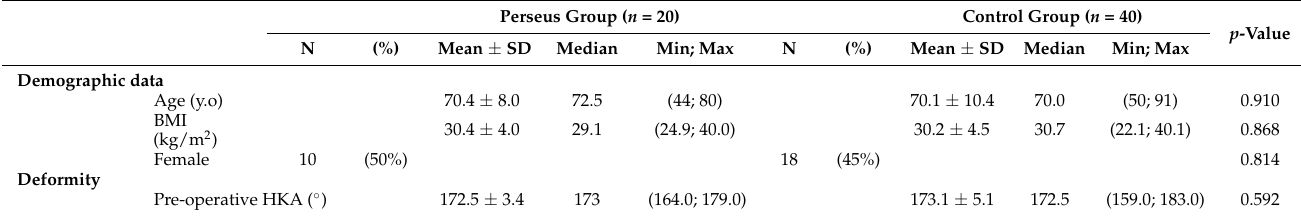
Table 1. Pre-operative